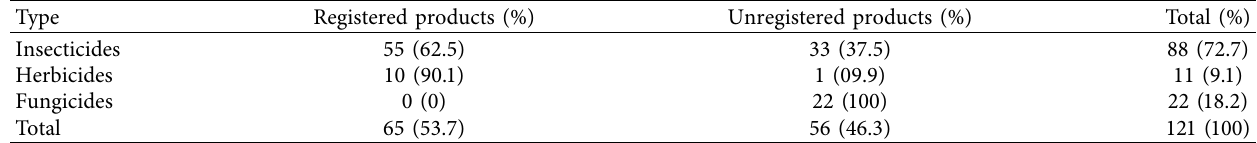
Table 2: Pesticide types, approved or not and used by gardeners.